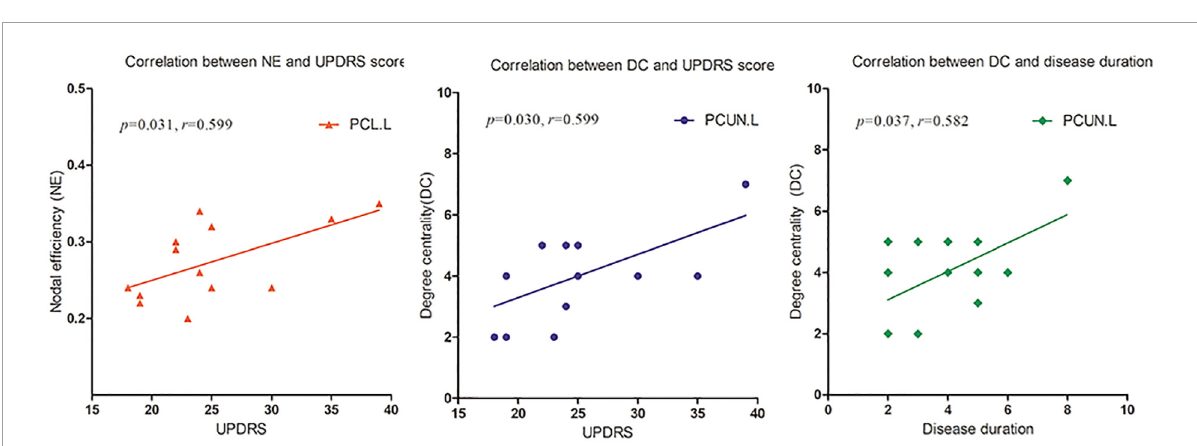
FIGURE5 The nodal efficiency (NE) of left paracentral lobule (PCL.L) and degree centrality (DC) of the left precuneus (PCUN.L) were significantly correlated with Unified Parkinson’s Disease Rating Scale (UPDRS) scores ( p = 0.031, r = 0.599; p = 0.030, r = 0.599). The DC of PCUN.L was also found to be significantly associated with disease duration ( p = 0.037, r = 0.582).